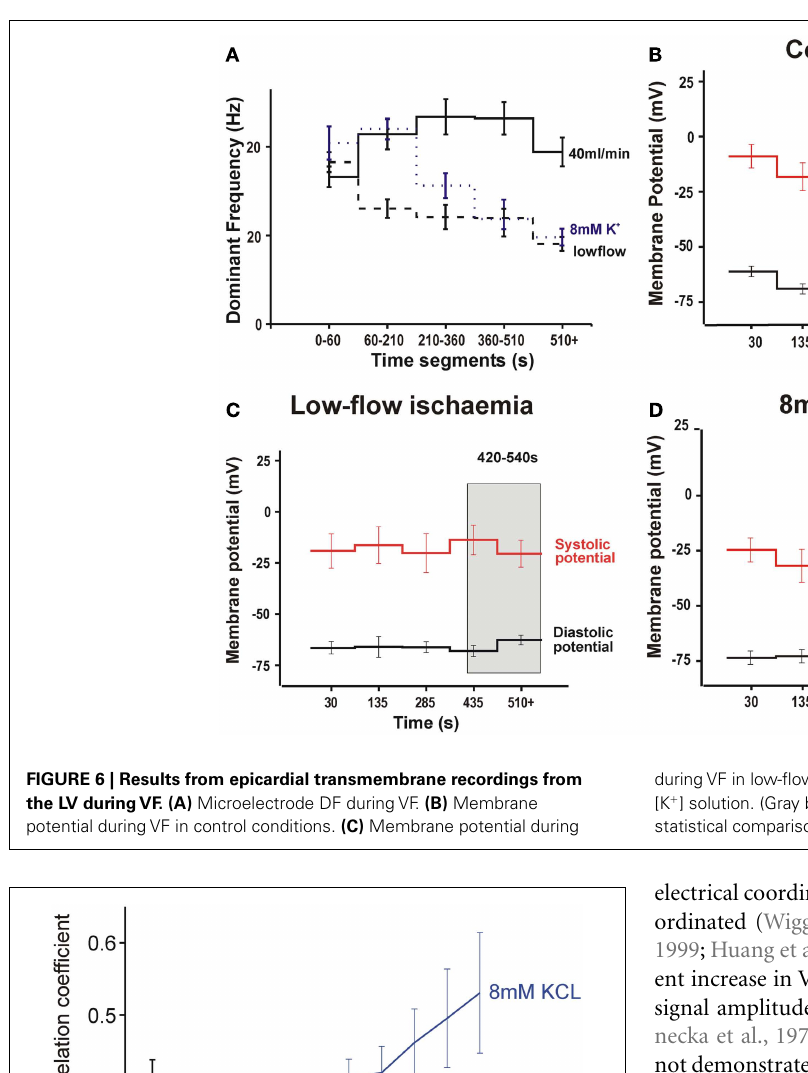
FIGURE 7 | Plot of mean correlation coefficient across the optical field with time. The correlation coefficient is seen to fall with time in control conditions, to be conserved in low-flow ischemia and to increase with time in [K + ] o